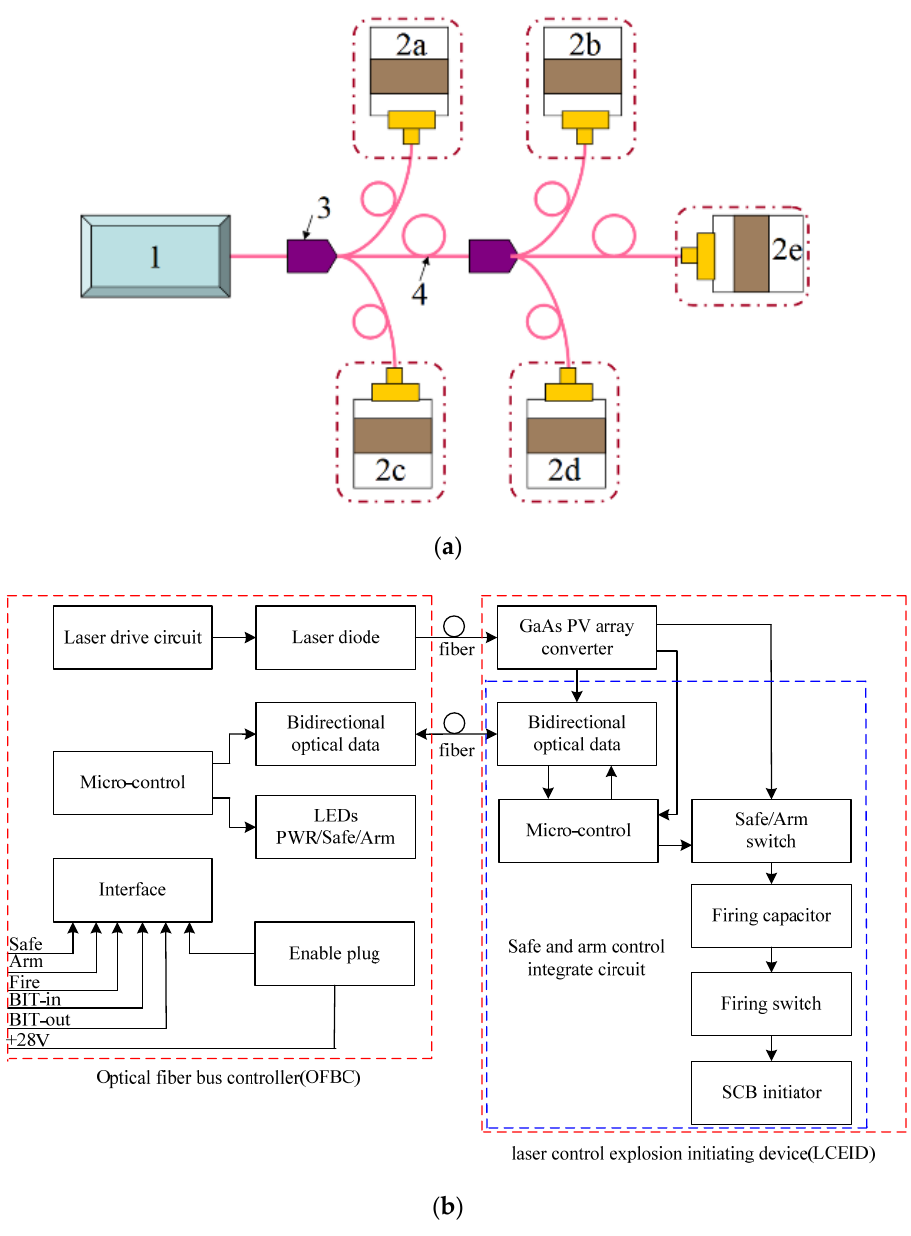
Figure 1. Schematic diagram of laser-controlled intelligent initiation system. ( a ) Multi-point initia- tion system: 1—OFBC; 2a~2e—LCEID; 3—optical coupler; 4—optical fiber bus network. ( b ) Schematic of single-point initiation system.